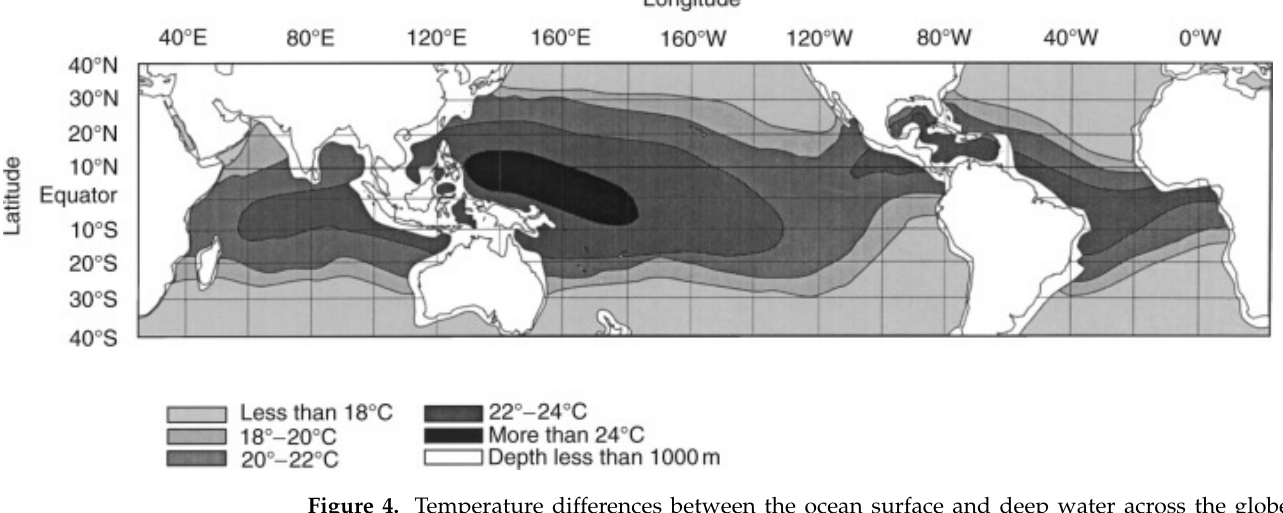
Figure 4. Temperature differences between the ocean surface and deep water across the globe (adopted from [72] with license no. 5240581259275).